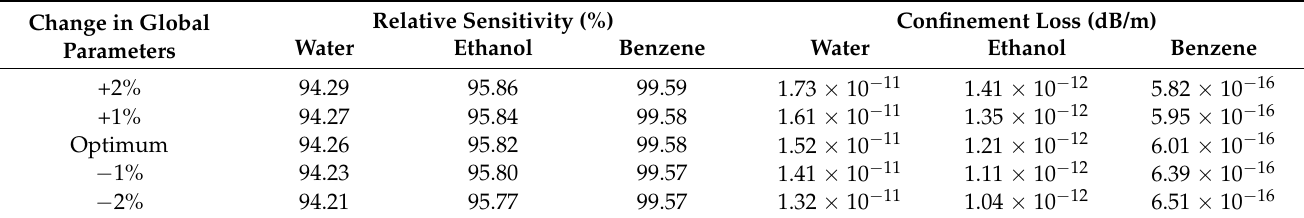
Table 1. Comparison among the variation in global parameters on optimum parameters at λ = 1.0 µ m. Change in Global Parameters